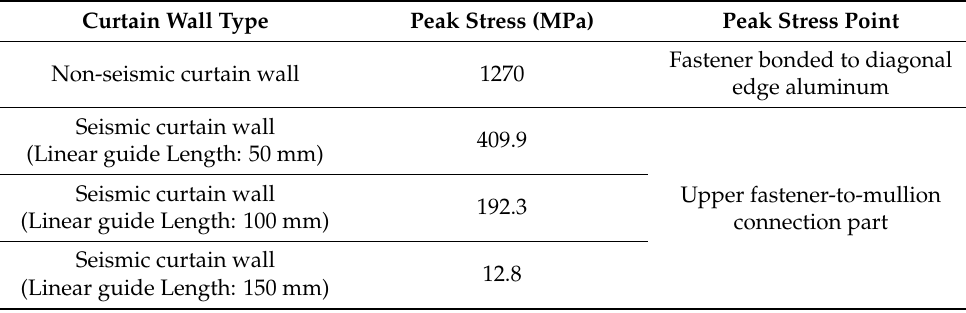
Table 11. Comparison of analysis results of non-seismic curtain wall and seismic curtain